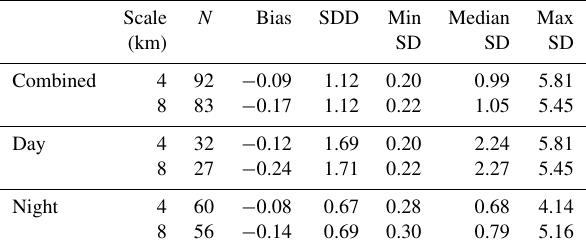
Table 5. Spatial homogeneity assessment of LST (K) using aggre- gates of 45 × 45 (4km) and 89 × 89 (8km) ASTER pixels at 90m resolution centered on the ARM SGP Central Facility for day, night, and combined times, using data from 2001 through 2015. The bias and SDD indicate the mean difference and standard deviation of the difference, respectively, of the ASTER central pixel relative to the 4.05 × 4.05 or 8.01 × 8.01km 2 average. Bias and SDD are based on granules N , which indicates the number of aggregates where at least 95% of the 90m pixels signified clear-sky conditions with no known defects and also represents the number of ASTER granules used to determine the region’s minimum, median, and maximum values of LST standard deviation